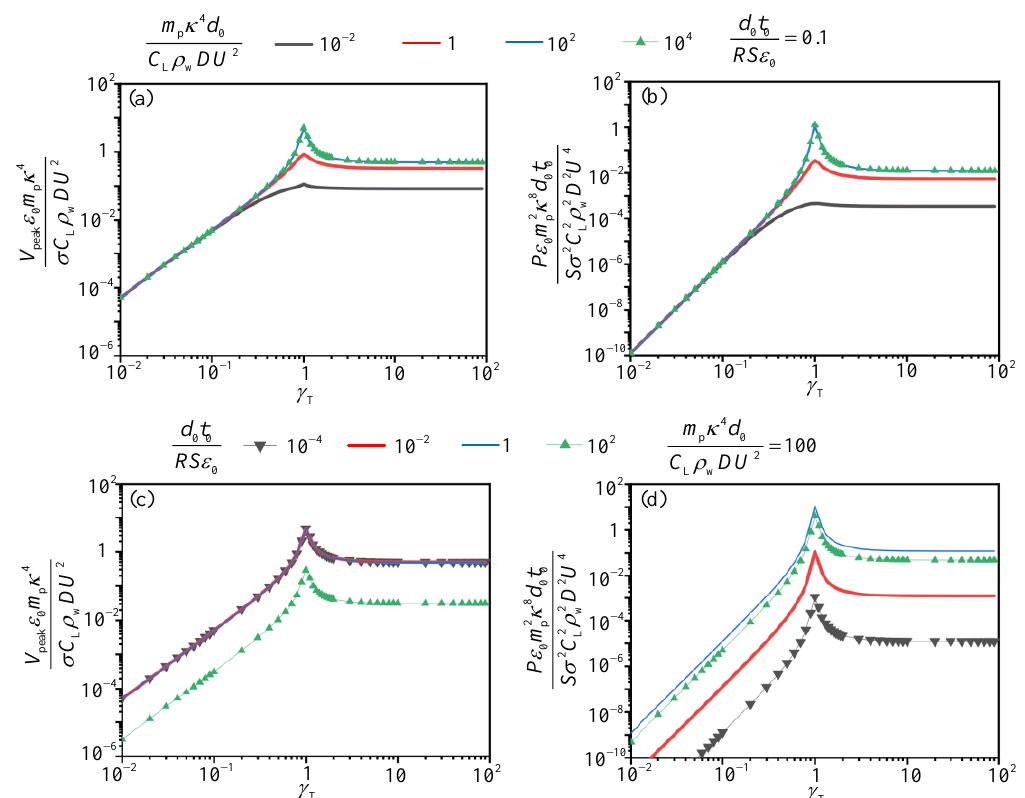
Figure 14. The normalized voltage V n2 and P n2 versus γ T . ( a , b ) are normalized voltage and power versus γ T with d 0 t 0 fixed; ( c , d ) are normalized voltage and power versus γ T with m p κ fixed.